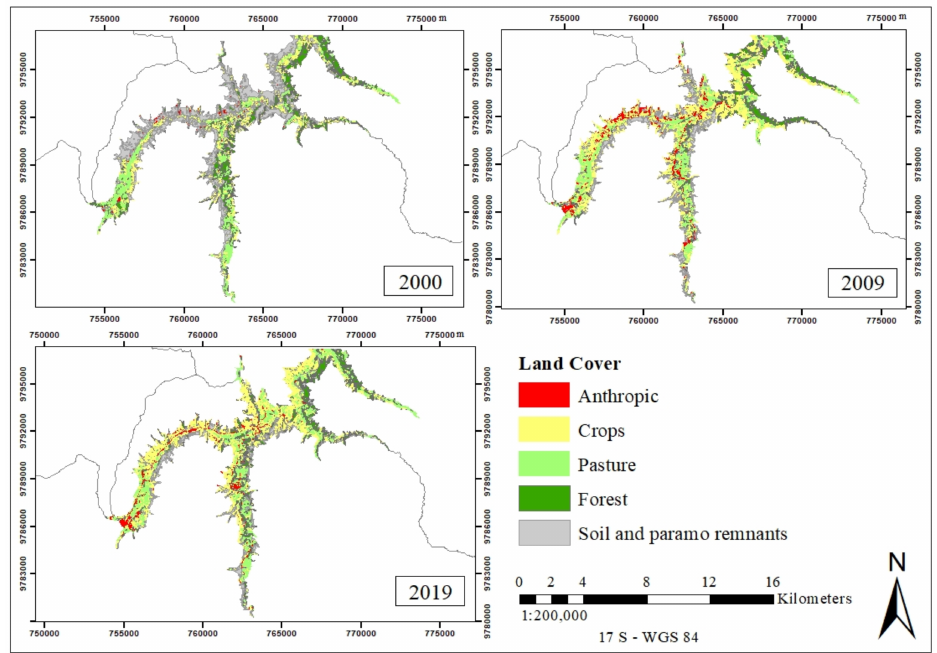
Figure 2. Map of the land cover of the study area in 2000, 2009, and